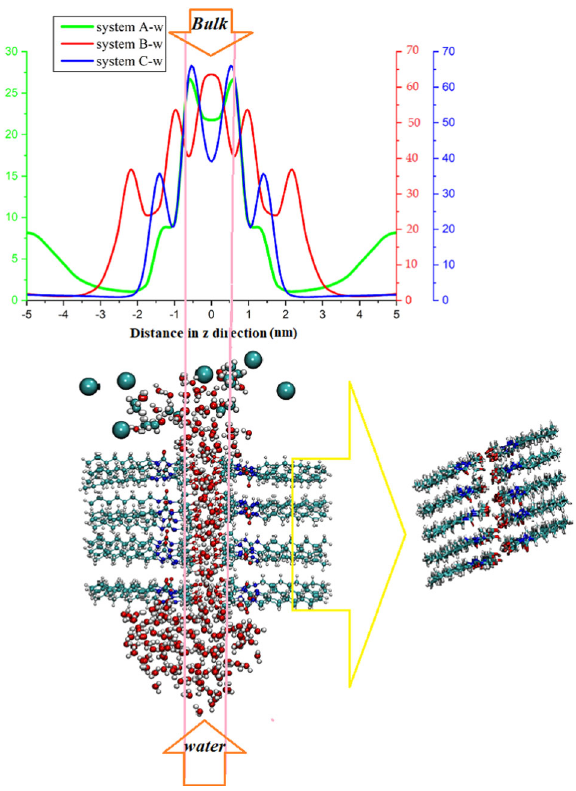
Fig. 7 Density pro fi le. The pro fi le density of water molecules toward OH channel.